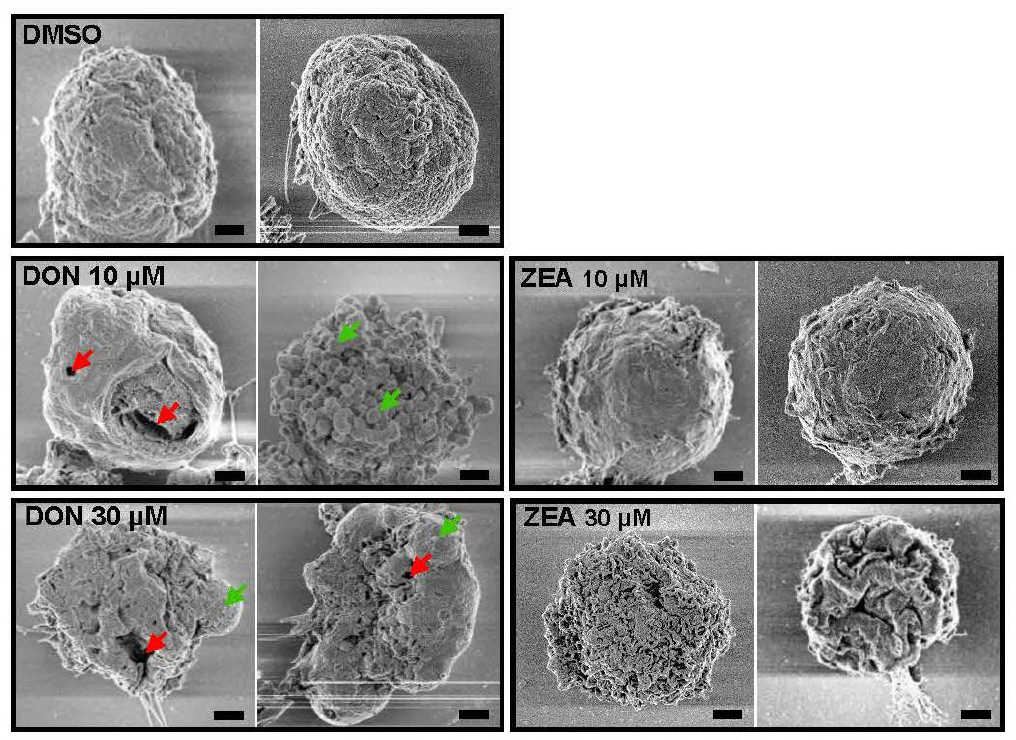
Figure 7. Representative scanning electron microscopy images of SCs treated with 10 μM and 30 μM DON and ZEA. Red arrows indicate membrane perforation, and green arrows indicate the apoptotic body-like cell protrusions. Bar indicates 1.0 μm in the DMSO, 10 μM and 30 μM ZEA groups. Bar indicates 1.5 μm in the 10 μM and 30 μM DON groups.